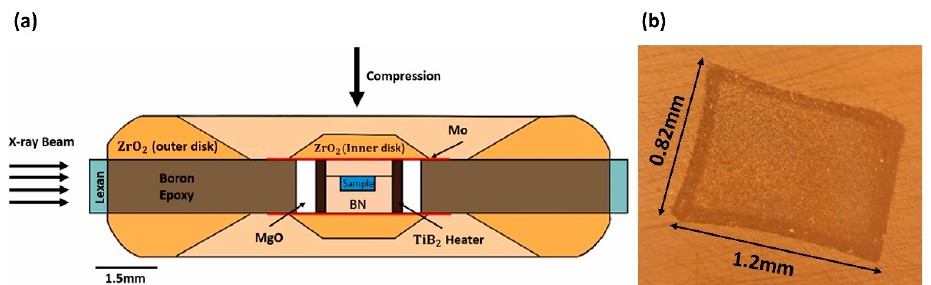
Figure 3. ( a ) Cupped Drickamer toroidal (CDT) employed in the high-pressure, high-temperature synthesis of high-entropy borides. The sample chamber contains a mixture of precursor materials depending on the desired composition. ( b ) The synthesized (Hf, Mo, Nb, Ta, Ti)B 2 sample of 1.2 × 0.82 mm was recovered for a detailed characterization of its physical and mechanical properties, as described in the text.